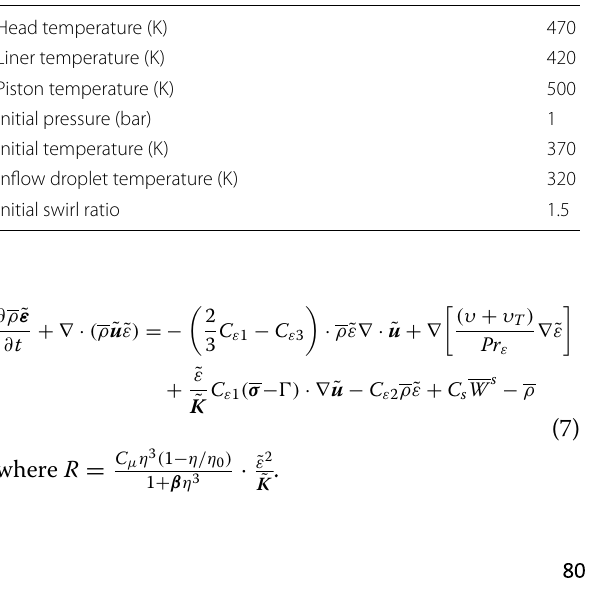
Table 7 Boundary and initial conditions